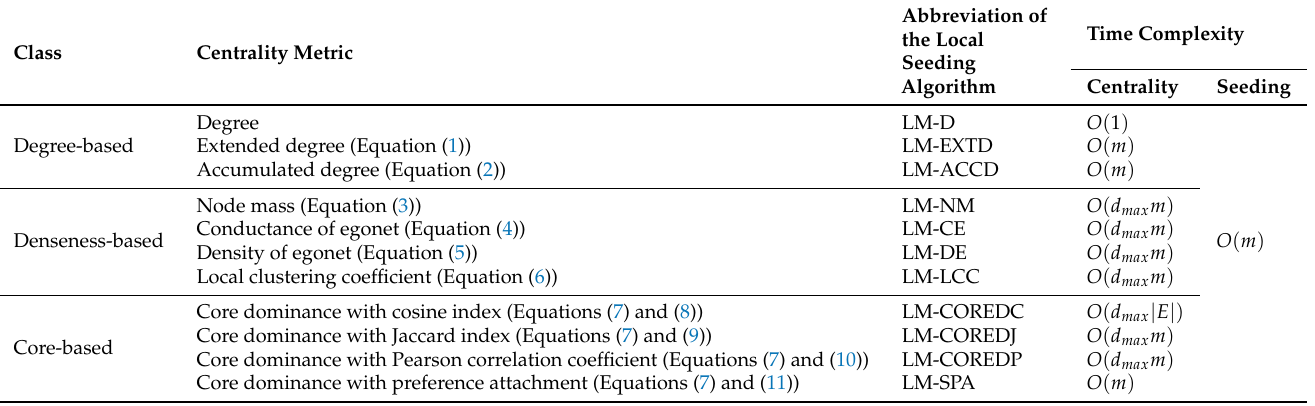
Table 2. The classes, abbreviations and time complexities of different local seeding